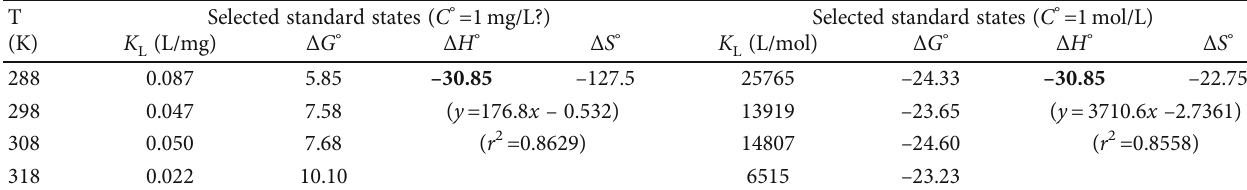
Table 2: Thermodynamic parameters for diclofenac adsorption onto F400 activated carbon [72].